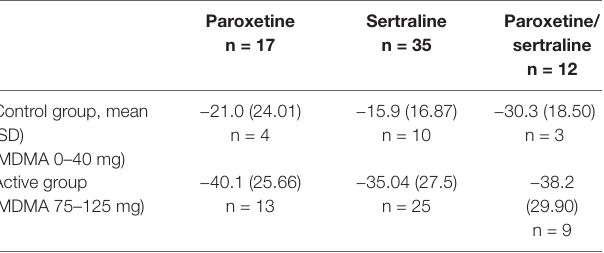
TABLE 2 | Mean change from baseline to the primary endpoint in CAPS-IV total scores in MAPS-sponsored phase 2 subjects who had previously taken sertraline, paroxetine, or both.